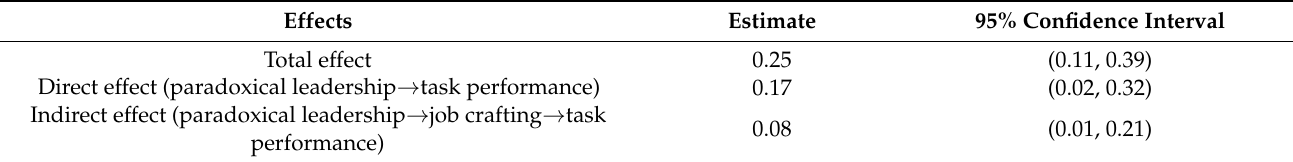
Table 4. Test of the mediating effect of job crafting.